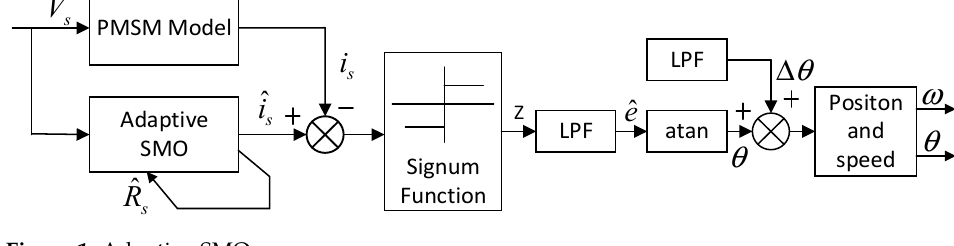
Figure 1. Adaptive SMO.